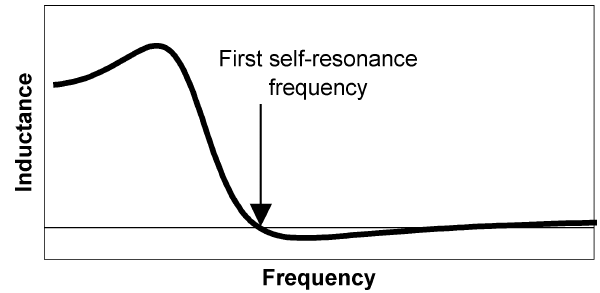
FIGURE 3 Typical integrated inductor